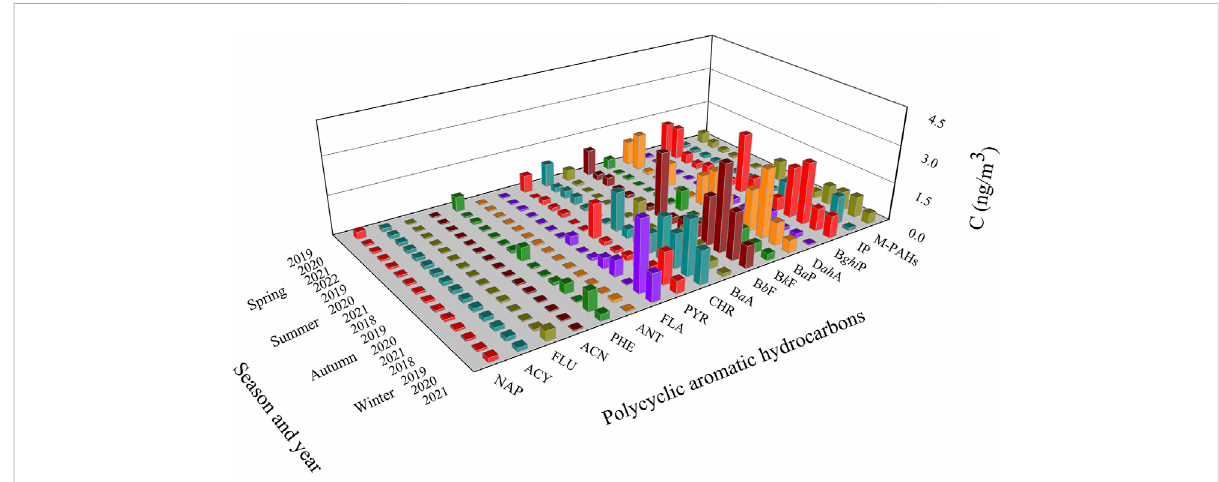
FIGURE 2 Box line statistics of different PAH concentrations in PM 2.5 during the study period from 2018 to